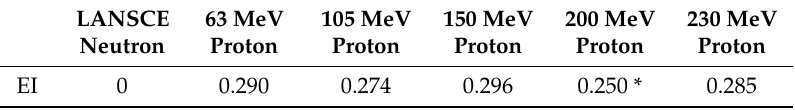
Table 1. Evaluation index (EI) for LET in layer structure without SiGe.